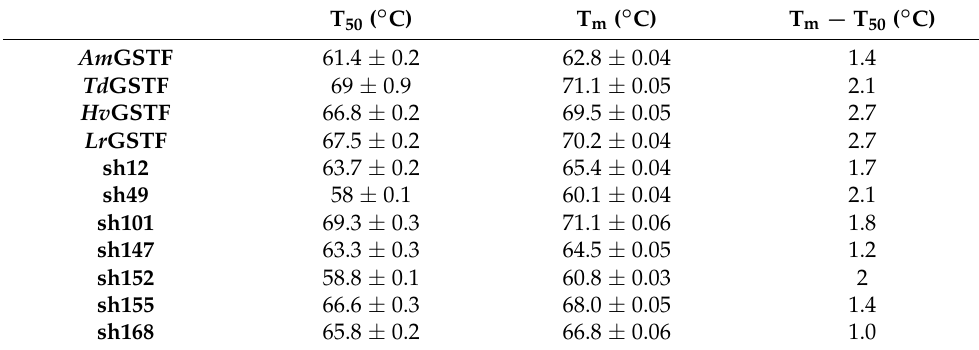
Table 3. Summary of T m and T 50 values as determined by thermal shift assay and thermal inactivation studies for the parent GSTFs and shuffled enzyme variants. The data represent the mean ± SD (N = 3). The T m − T 50 was calculated by the established mean